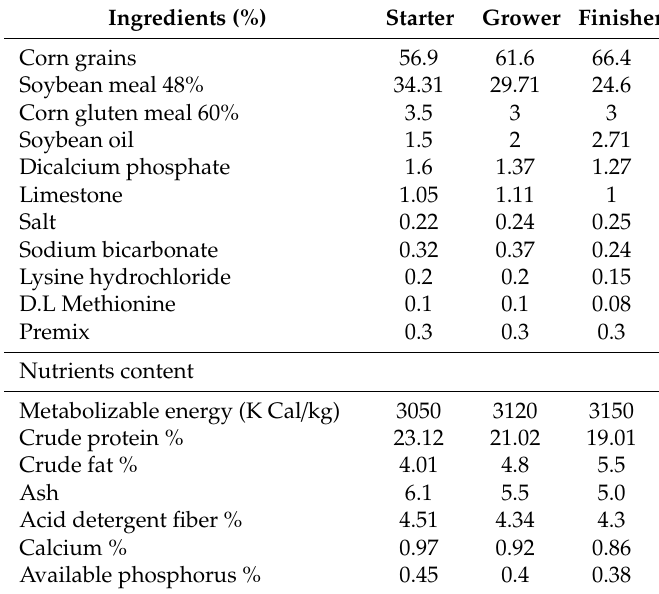
Table 1. Ingredients, composition and nutrient content of starter, grower and finisher